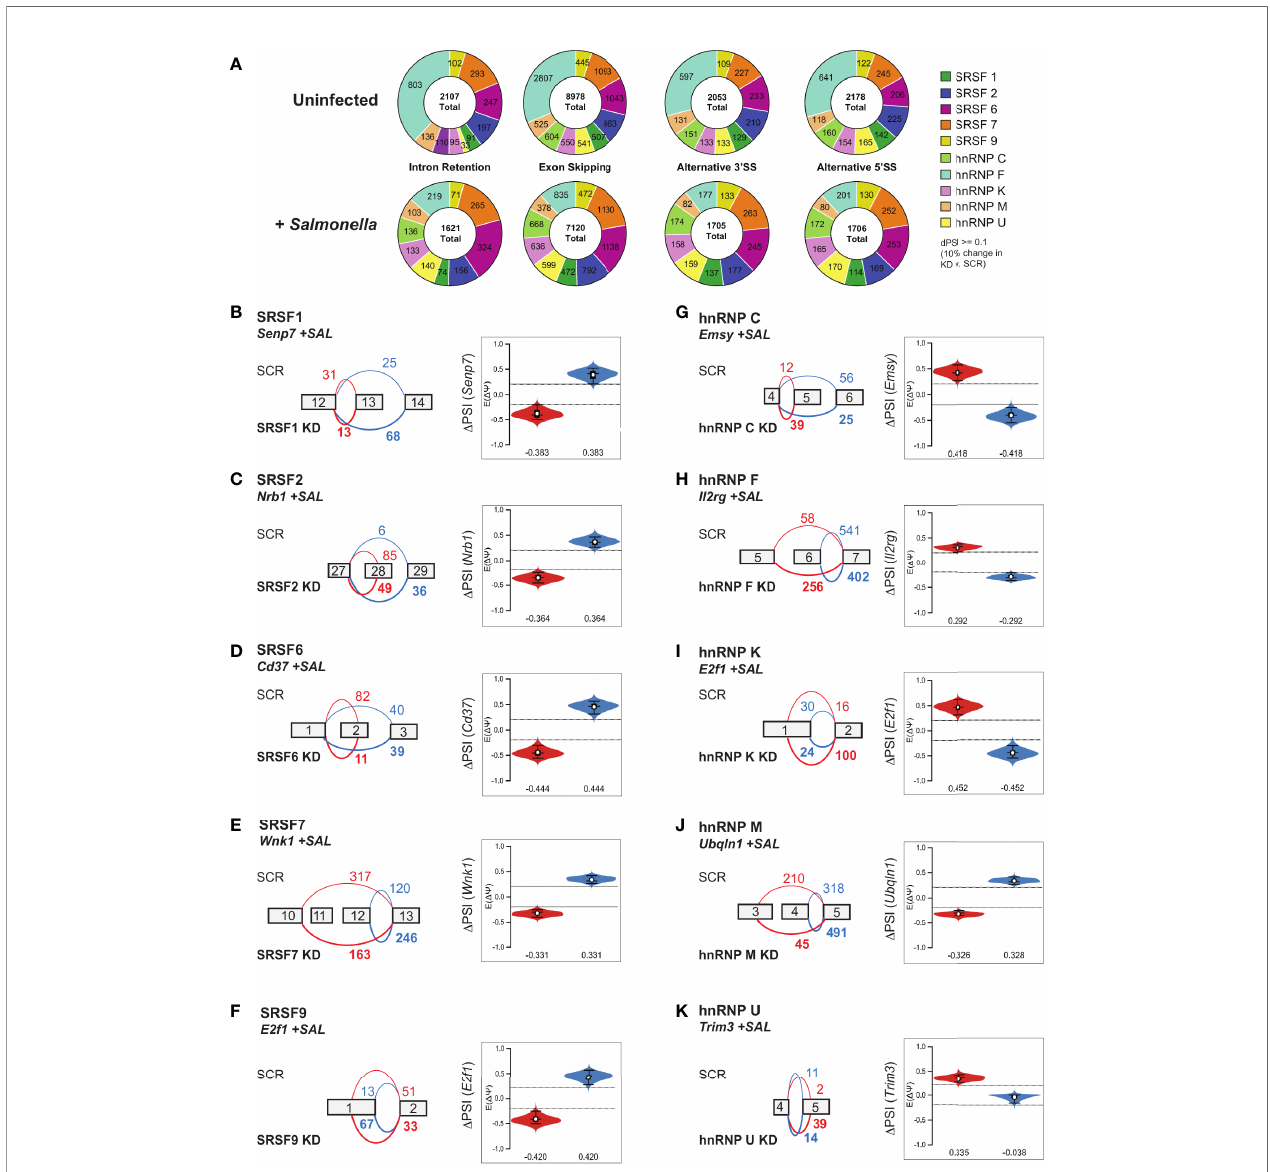
FIGURE 5 | Local splicing variationsare abundant in SR/hnRNP knockdownmacrophages, but they donot preferentially occurin SR/hnRNP-dependent differentially expressed genes. (A) Quantitation of intron retention,exon skipping, alternative 3 ’ and 5 ’ splice site events in uninfectedand Salmonella -infected SR and hnRNP knockdown macrophages (probability [ ∣ delta PSI ∣ , ≥ 10%], >95%). PSIis de fi ned as “ Percent Spliced In ” andindicates the abundance of a particular alternativelysplicedisoform. D PSI indicates the abundance of an isoformin knockdown vs. SCR macrophage cell lines. (B) (left) VOILAoutput, basedonRNA-seq reads, of affectedexonsin a representative gene (Senp7)in SRSF1knockdown or SCR RAW 264.7 cellsinfected with Salmonella . (right) Violin plots depicting the D PSI of the SRSF1-dependent local splicing variations of Senp7 . Violin plot colorscorrespondto the events depicted inthe gene schematicon the left. (C) As in (B) but for SRSF2 and Nrb1 . (D) As in (B) but for SRSF6and CD37 . (E) As in (B) but for SRSF7 and Wnk1. (F) As in (B) but for SRSF9and E2f1. (G) As in (B) but for hnRNP C and Emsy. (H) As in (B) but for hnRNP F and Il2rg. (I) As in (B) but for hnRNP K and E2f1. (J) As in (B) but for hnRNP M and Unqln1. (K) As in (B) but for hnRNP U and